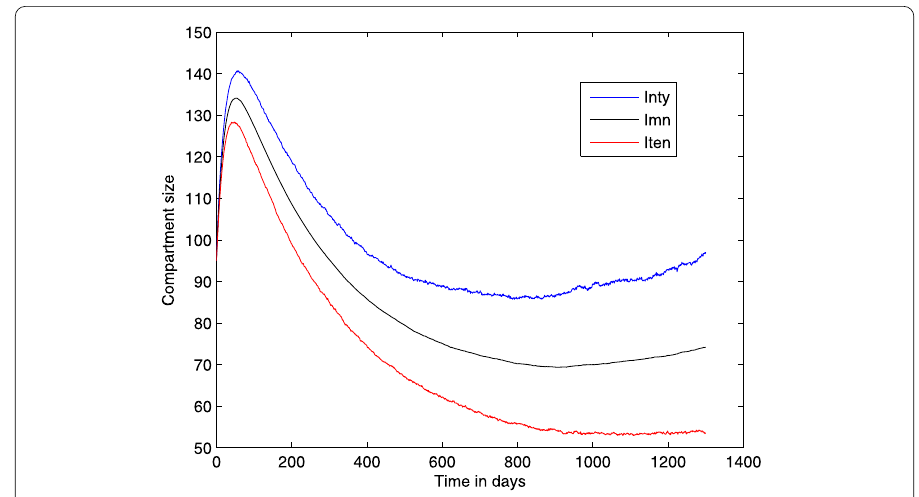
Figure 2 The mean I -path of 4000 runs, the first and ninth deciles [ σ = ζ = 5 × 10 –6